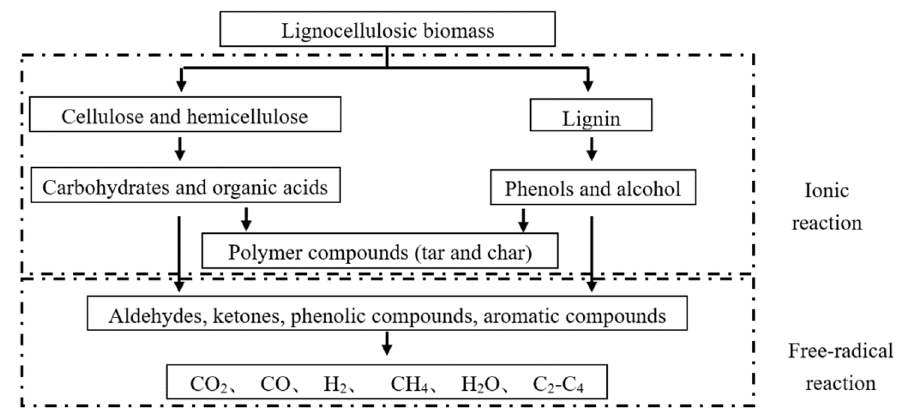
Figure 7. HTG mechanism of lignocellulosic biomass.